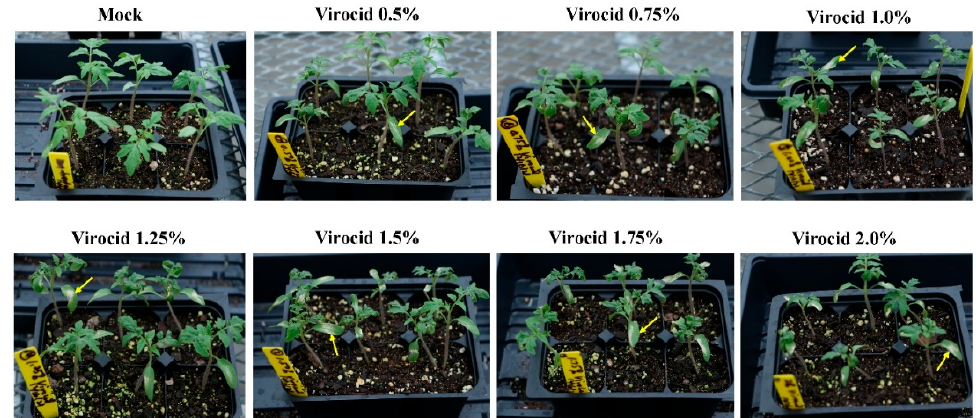
Figure 5. Phytotoxicity was observed on inoculated leaves in test plants treated with Virocid in serial dilutions (0.5% to 2%) on cotyledon and/or first leaf, with necrotic lesions. These injured plants were able to recover as plants continued to grow.